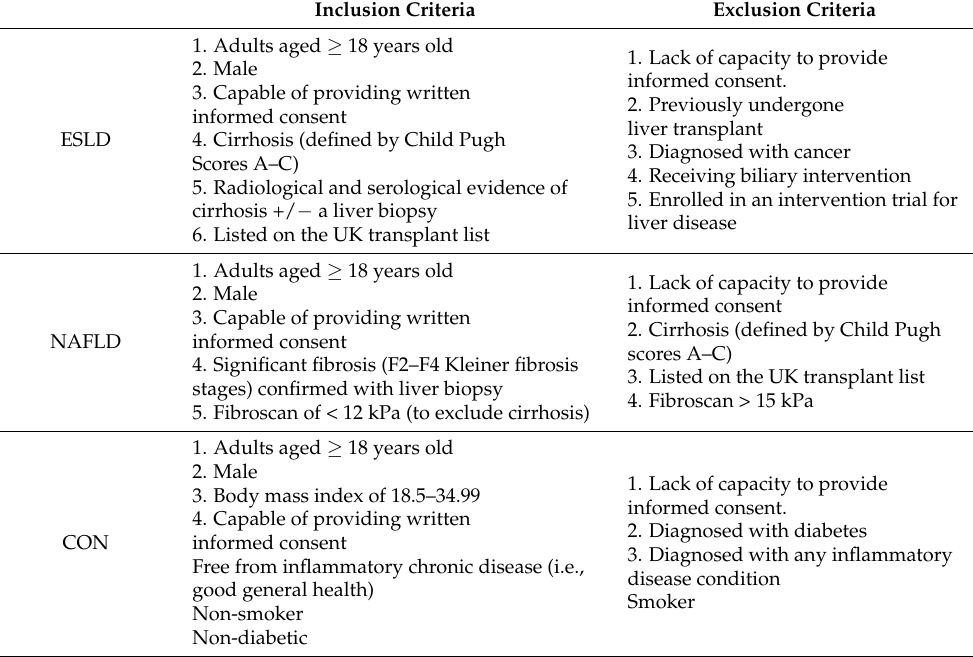
Table 1. Inclusion and Exclusion